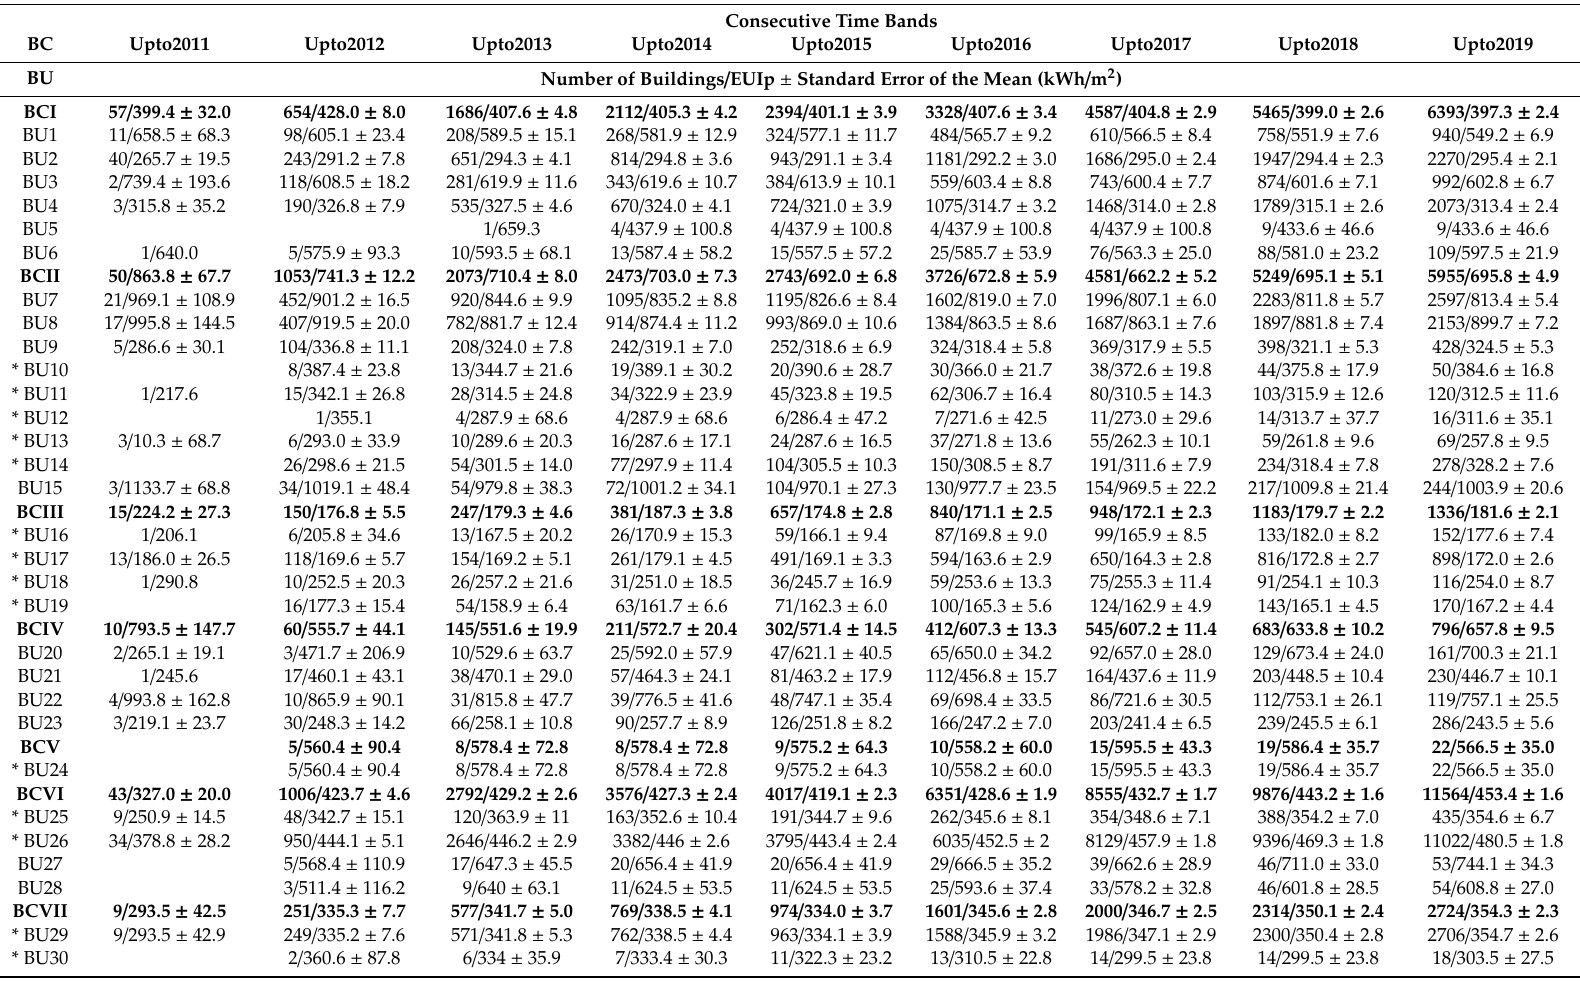
Table 2. Time evolution of number of EPCs and calculated average total primary energy use for the di ff erent building categories and building uses in the NR